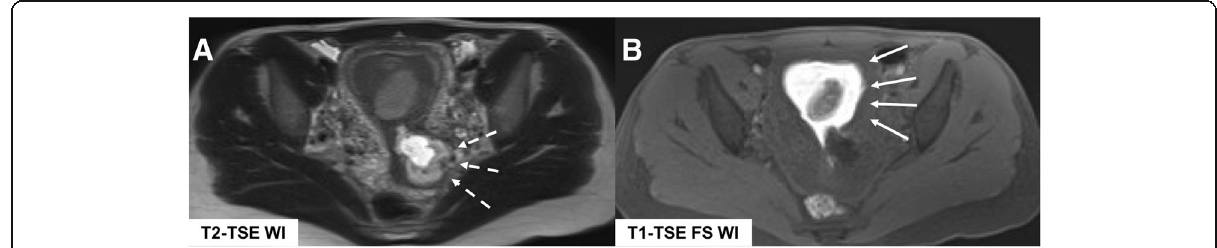
Fig. 14 Cesarean scar ectopic pregnancy MR: T2-WI ( a ) show the gestational sac embedded in the myometrium of the anterior cervix – lower uterine segment (in this case antero-lateral, dashed arrow). T1-WI ( b ) demonstrates endometrial cavity distension by blood with endoluminal clots (white arrows) and the continuity between endometrial cavity and gestational sac